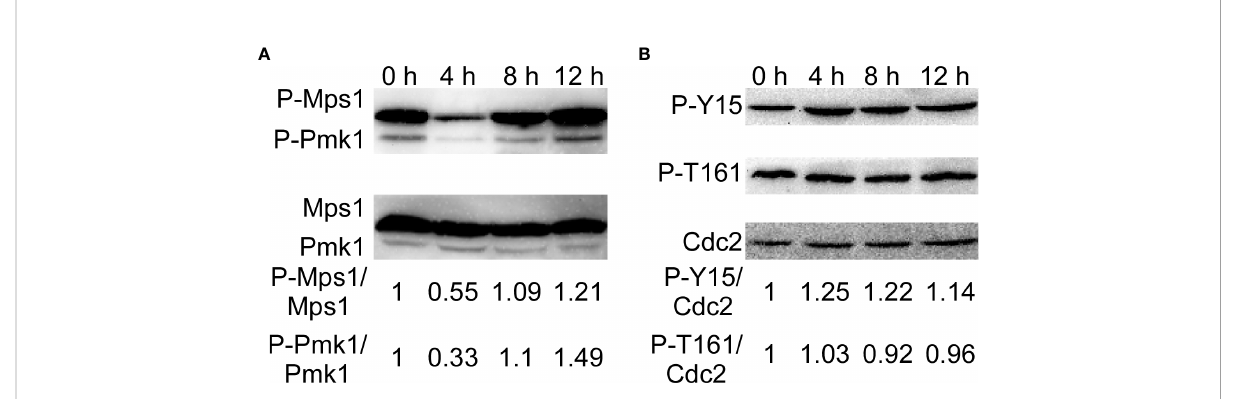
FIGURE 9 KC81 SUP activates phosphorylation of Mps1-, Pmk1- MAPK, and MoCdc2. (A) Western blot assays for phosphorylation of Mps1 and Pmk1. (B) Western blot assays for phosphorylation of